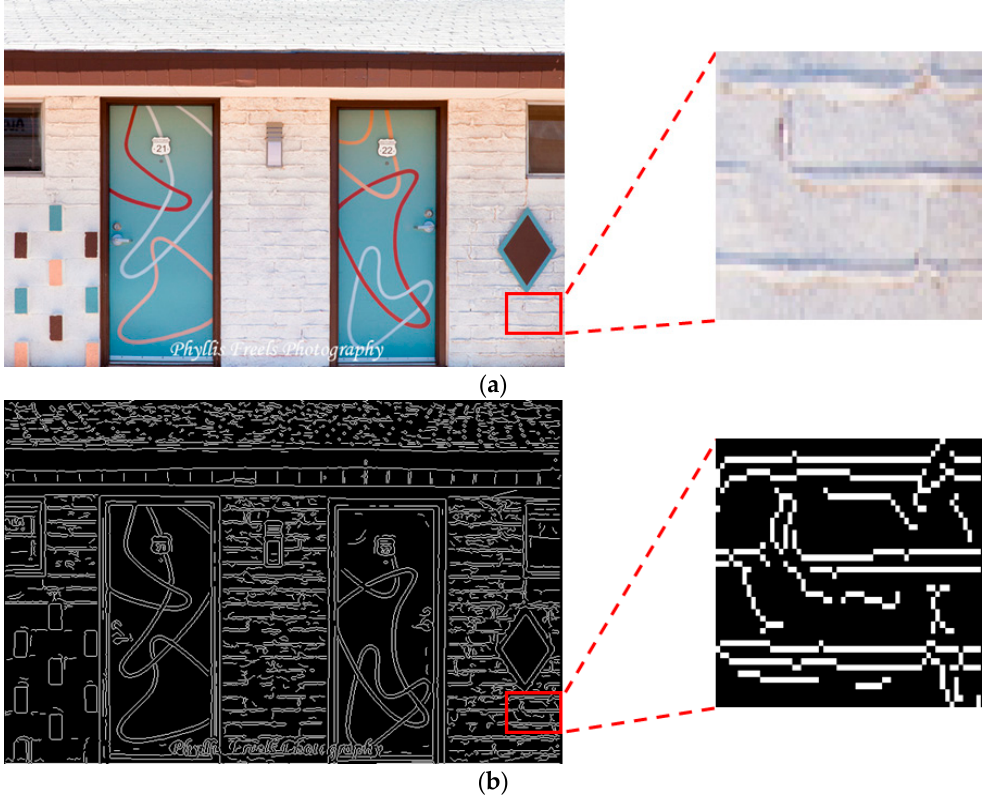
Figure 13. The effect of the proposed algorithm on edge detection. ( a ) Original image; ( b ) image after edge texture construction.